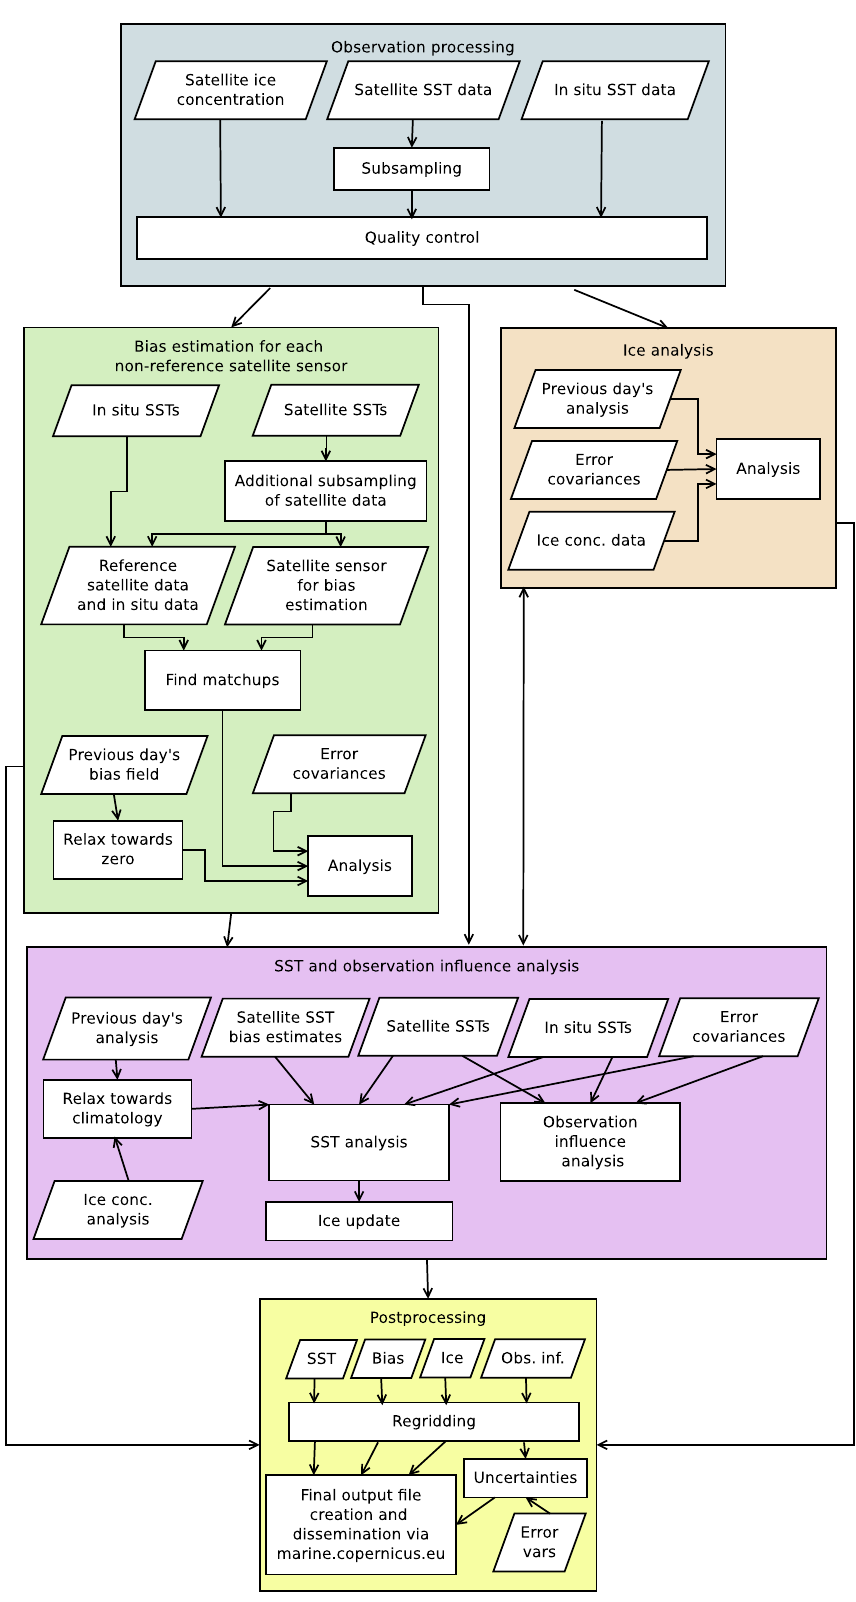
Figure 1. Diagram of the Operational Sea Surface Temperature and Sea Ice Analysis (OSTIA) processing system, showing the principal components of the system and the dependencies between